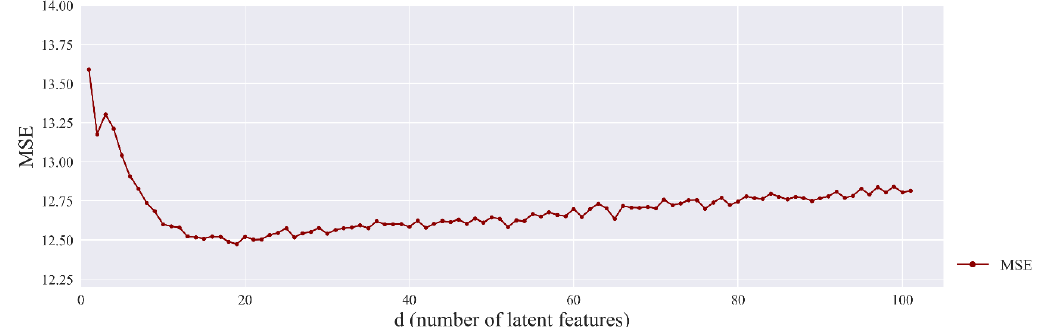
Figure 3. 10-fold cross-validation results for rating predictions.